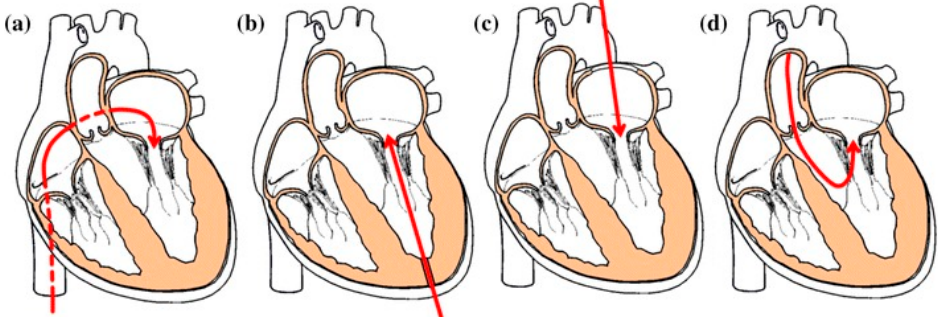
Figure 4. Transcatheter mitral valve delivery approaches: ( a ) transseptal, ( b ) transapical, ( c ) left atriotomy, ( d ) transaortic [101].